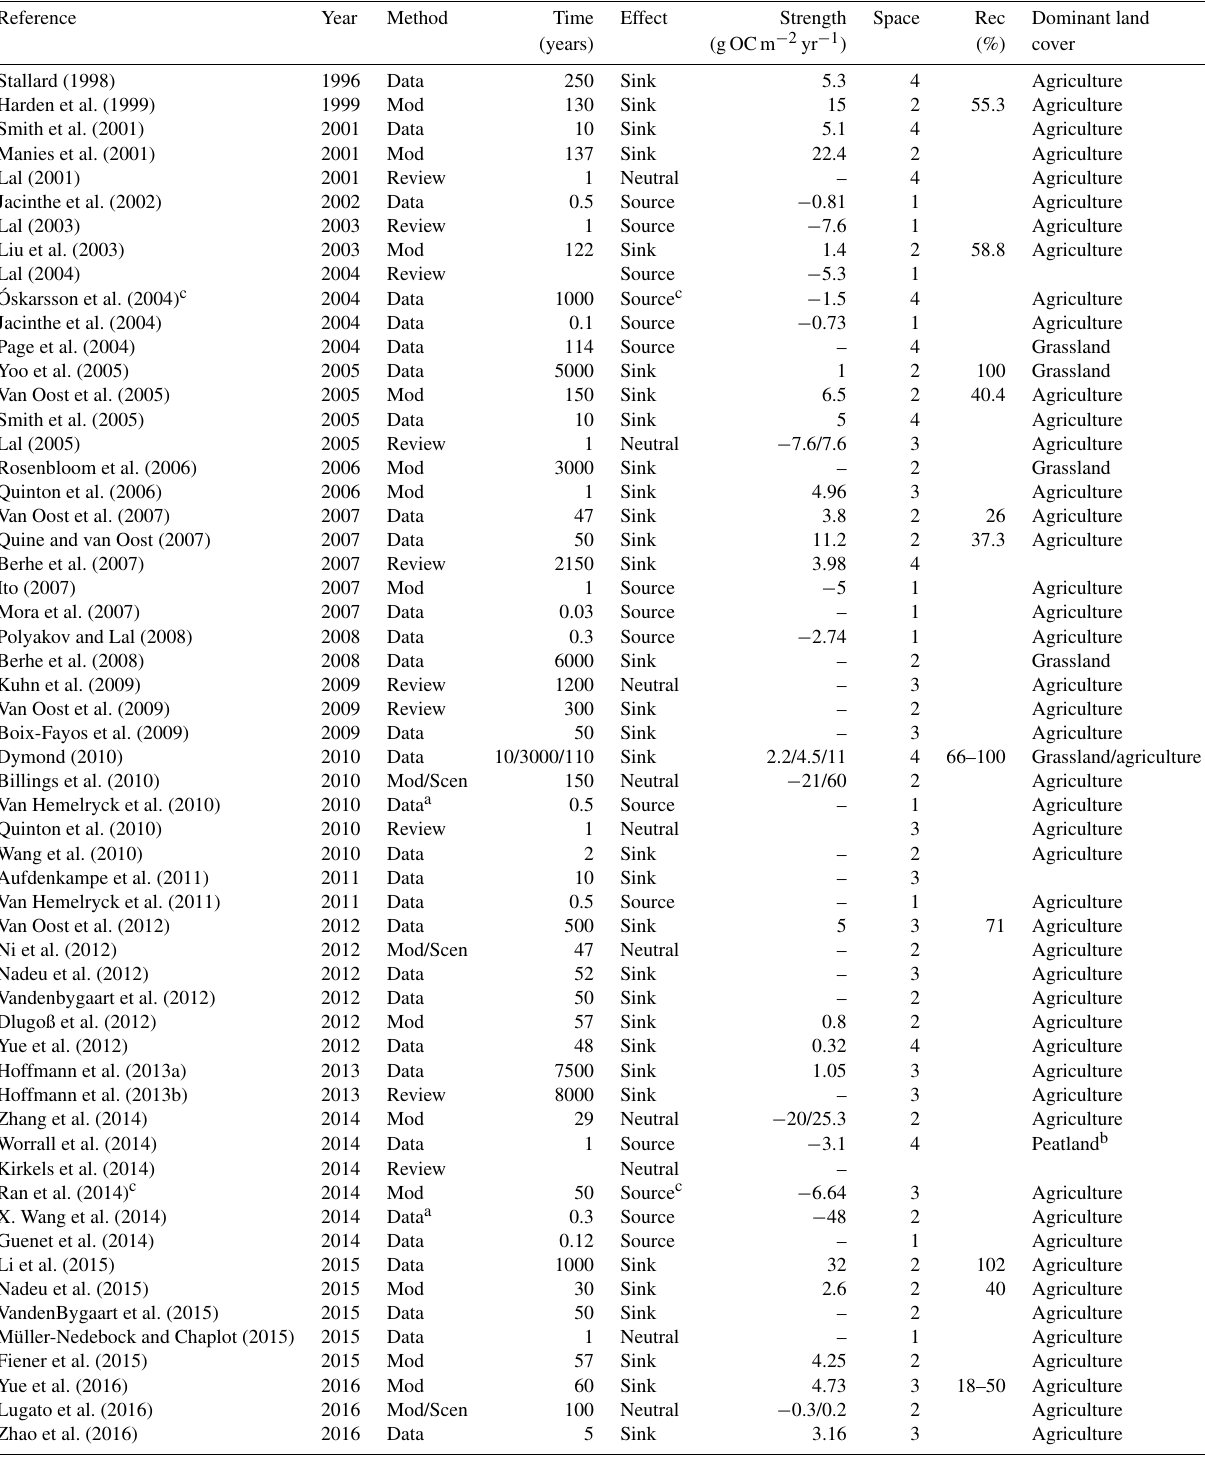
Table 1. Overview of studies reporting erosion-induced OC fluxes used in our literature synthesis. Space refers to the four components of the geomorphic cascade (see Fig. 2 for key). Positive values for OC strength denote a sink, while negative values denote a source. Methods are categorized as “Data” or “Mod” (model) based. Modeling studies using scenario analysis are reported as “Mod/Scen”, and a range for the sink–source strength is given. “Rec” denotes the fraction (in %) of the eroded OC that is replaced with atmospheric derived OC. Studies assuming steady state were assigned a timescale of 1